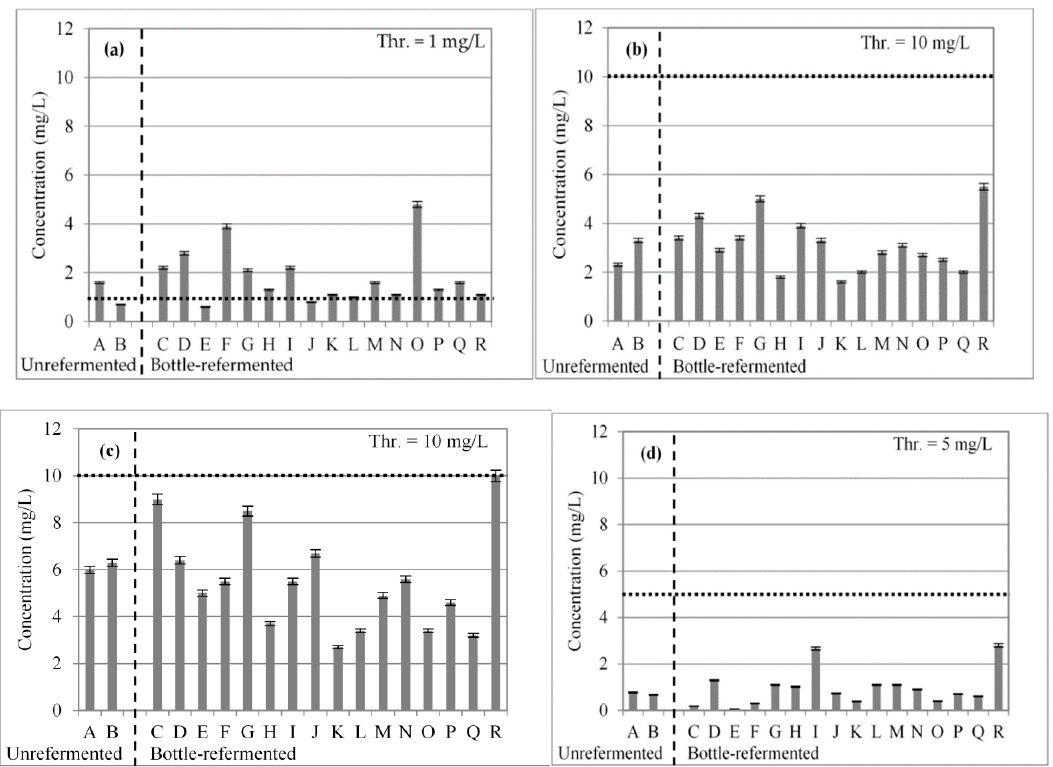
Figure 1. Concentrations of isovaleric ( a ), hexanoic ( b ), octanoic ( c ), and decanoic ( d ) acids (mg/L) in 18 fresh Belgian craft beers. The dotted lines in each graph indicate the compound sensory threshold (Thr.).